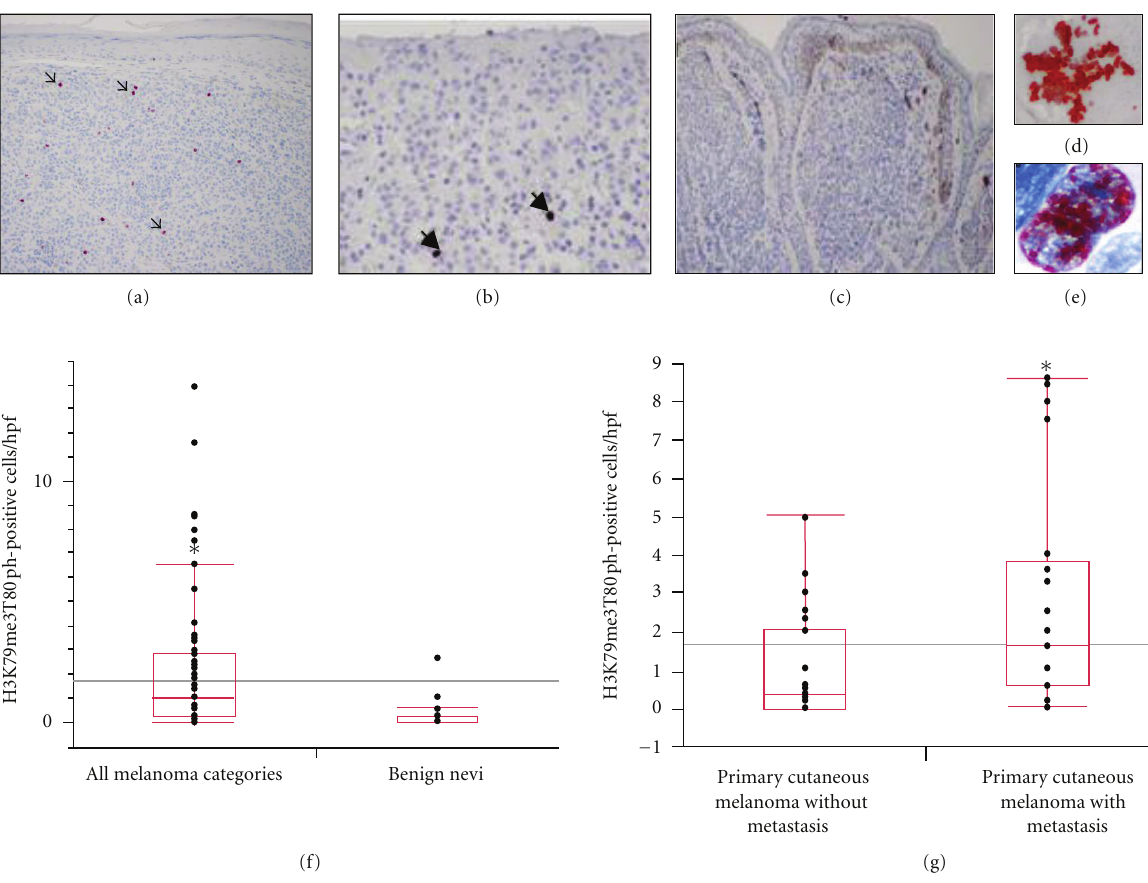
Figure 5: Immunohistochemistry (IHC) H3K79me3T80ph detects a subset of primary cutaneous melanomas with metastatic potential. Positive H3K79me3T80ph cells (arrows) in: (a) metastatic melanoma of the skin (magnification: × 100) and (b) primary cutaneous invasive melanoma (magnification: × 200) (c) Melanocytic nevi with absence of H3K79me3T80ph labeling (magnification: × 100). (d) and (e) Representative H3K79me3T80ph staining of melanoma tissue microarray (d): mitotically active cells, (e): melanoma cells with speckled nuclear staining pattern (Magnification: × 400). (f) and (g) Box graph analysis of the number of H3K79me3T80ph positive cells per high powered field (h.p.f.) within the melanocytic neoplasms contained in the tissue microarray. (f) Melanoma from all categories demonstrates greater number H3K79me3T80ph positive cells compared to benign nevi ( P = 0 . 0019). (g) Significant labelling of H3K79me3T80ph positive cells in primary cutaneous melanomas with known metastasis compared to primary melanomas without metastasis ( P = 0 .